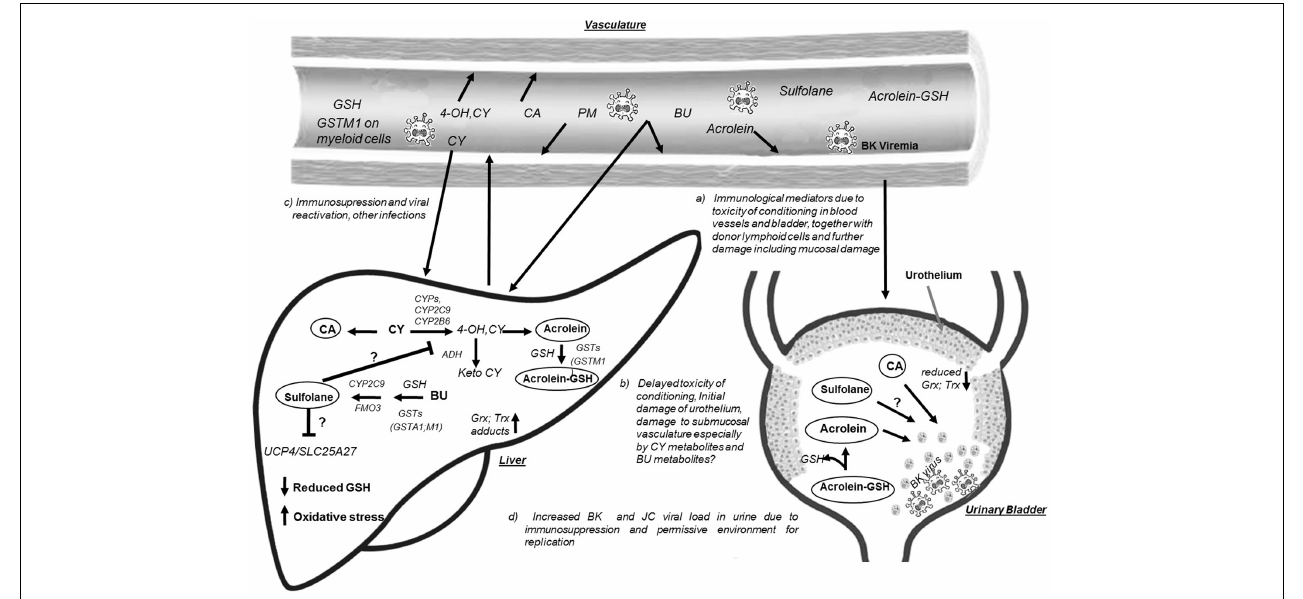
FIGURE 1 | Hypothetical model for Hemorrhagic Cystitis occurrence in children receiving BU-CY regimen prior to allogeneic HSCT. Busulfan (BU) and cyclophosphamide (CY) metabolism predominantly occurs in the liver generating the water soluble metabolites sulfolane (Su) and acrolein (Ac), respectively. During the metabolic process BU utilizes glutathione (GSH) and activity of GSTs such as GST alpha 1 (GSTA1), GST mu1 (GSTM1) plays an important role in conjugation of BU with GSH. GSH is also essential for scavenging the CY active metabolites including Ac also catalyzed by GSTs. When CY is administered after BU, the water soluble metabolite of BU, i.e., Su could influence the activity of cytochrome P 450 enzymes (CYPs) and thus might affect the activation of CY, or on the other hand higher Su levels also represents the utilization of GSH and formation of γ -glutamyl-dehydroalanyl-glycine (EdAG) affecting the availability of reduced form of GSH. Su might also affect the function of GSTs and other enzymes in BU, CY metabolism and proteins such as Mitochondrial uncoupling proteins (UCP) encoded by SLC25A27 gene affecting cell survival. Su possibly affect the function of ADH (alcohol dehydrogenase) enzyme resulting in increased levels of hydroxy CY metabolite, resulting increased Ac formation. BU could irreversibly alkylate the glutaredoxins (Grx) and Thioredoxins (Trx) increasing the oxidative stress, thus increasing toxicity of incoming CY metabolites such as 4 hydroxy cyclophosphamide (4OH-CY); Ac, chloro acetaldehyde (CA), and Phosphoramide mustard (PM). Altered activity of CYPs due to less functional alleles in the encoding genes might have a predictable function of Su formation and CY activation. Circulating CY metabolites (4OH CY, PM) including Ac inhibit cytokine function by alkylation and also cause immunosuppression, further increasing the chances of viremia and viruria (BK and/or JC virus). Ac conjugated with GSH in the liver gets delivered to the bladder and releases free Ac which then could alkylates cysteine residues and causing toxicity. Altogether increased rate of metabolite delivery to the urinary bladder together with viral load and lack of protection due to increased oxidative stress, endothelial damage to the blood vessels, urothelial damage and enhanced viral replication results in bladder inflammation and hematuria and the condition hemorrhagic